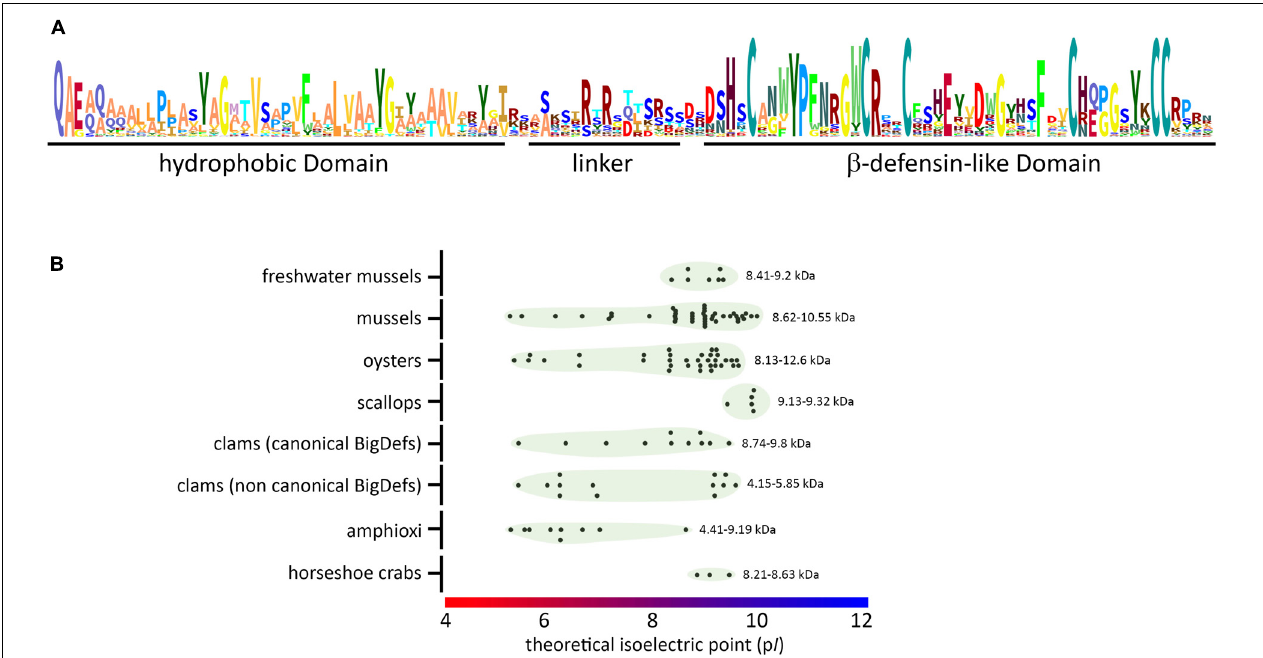
FIGURE 7 | Conserved molecular patterns and diverse biophysical properties of big defensins. (A) Schematic view (sequence logo) of the conserved amino acids found in big defensins. (B) Variability of isoelectric point (p I ) and molecular weight (kDa) among big defensins from different taxa. Black dots represent single big defensin sequences from each taxon, and green circles indicate the dispersion of the p I values (indicated on the X axis). At the right side of each group, the range of deduced molecular weight is presented (kDa).